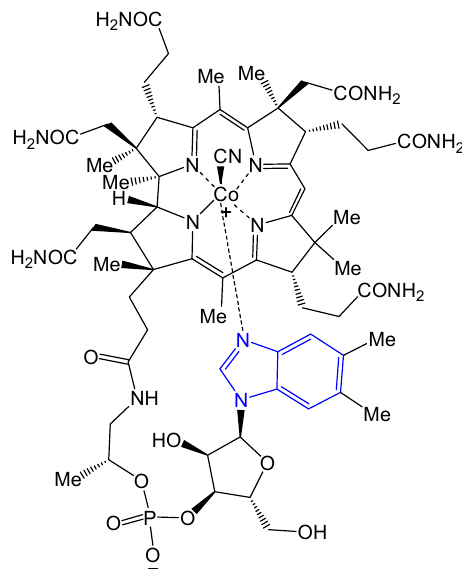
Figure 1. Benzimidazole nucleus in vitamin B 12 .